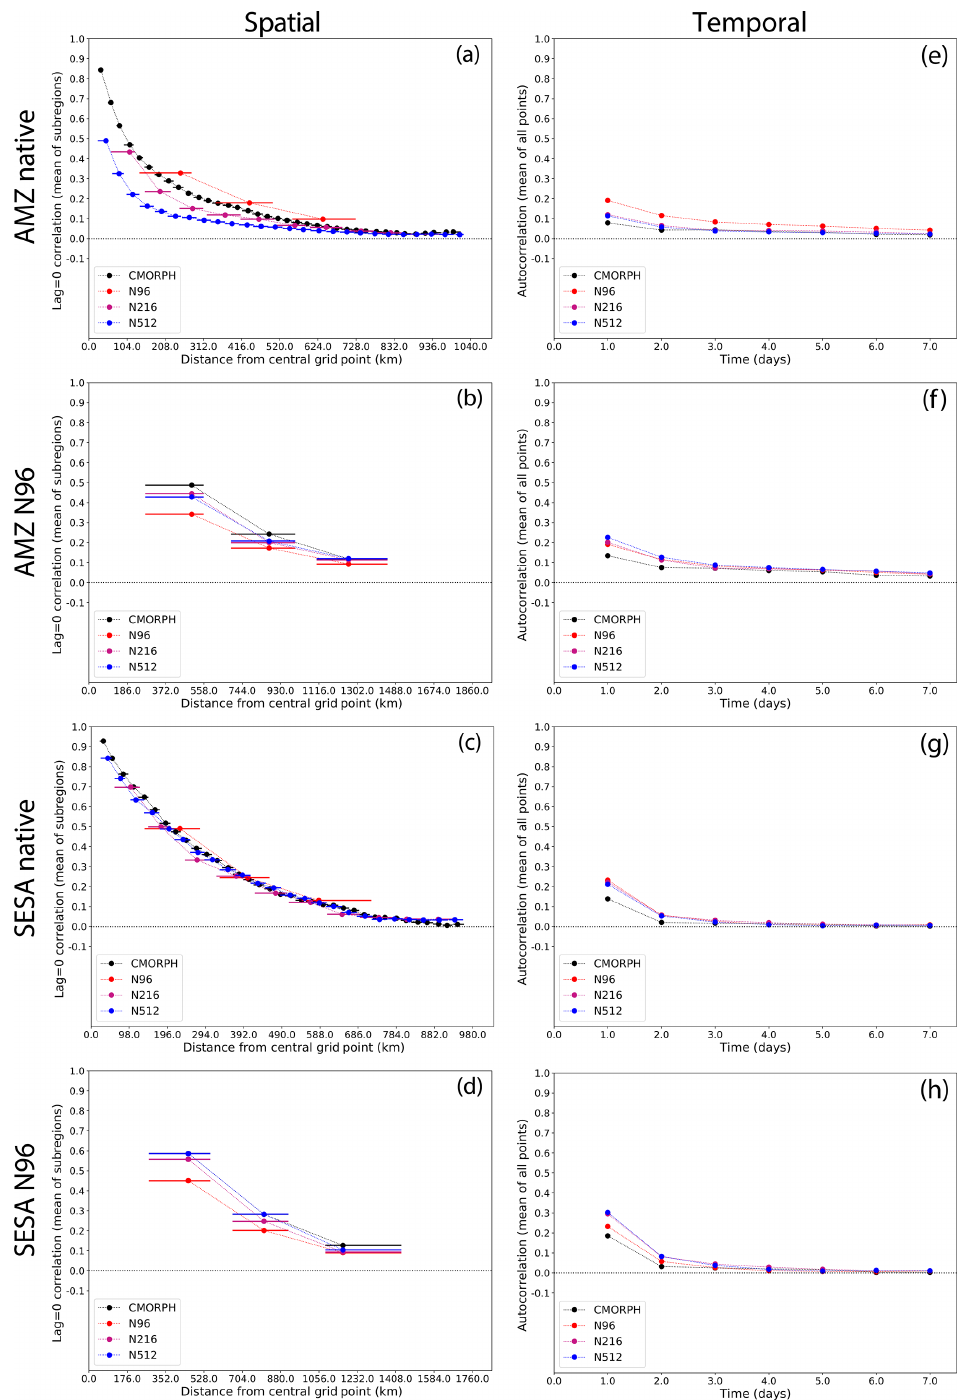
Figure 13. (a) Metric of the spatial scale of daily precipitation (at native resolution), computed by dividing the analysis domain into 1500km × 1500km subregions and calculating the mean lag-0 correlation between the central grid point and all grid points within each distance bin (which are 1 x wide, starting from 0 . 51 x ) away from the central grid point and then averaging the correlations over all subregions in AMZ; (e) metric of the temporal scale of daily precipitation, computed as the autocorrelation at each point, averaged over all points AMZ. The horizontal lines in (a) – (d) show the range of distances spanned by each distance bin; the filled circle is placed at the median distance. For clarity, we omit the correlations for zero distance and zero lag, which are 1.0 by definition. Panels (b) and (f) are the same as (a) and (c) respectively for all datasets on the N96 grid; (c–d) and (g–h) are the same as (a–b) and (e–f) respectively but for